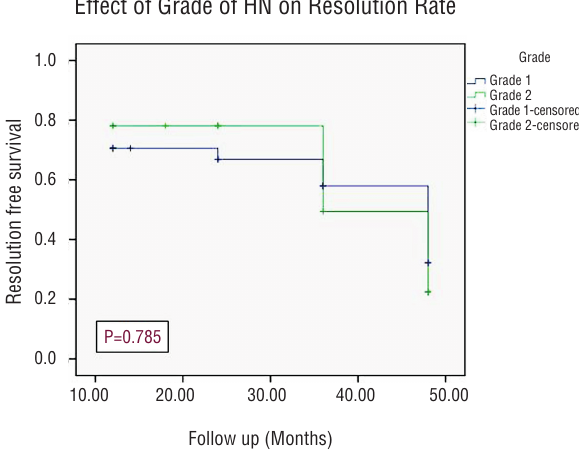
figure 4 - Kaplan-Meier curve Showing Incidence of Resolution Stratifying By Grade of